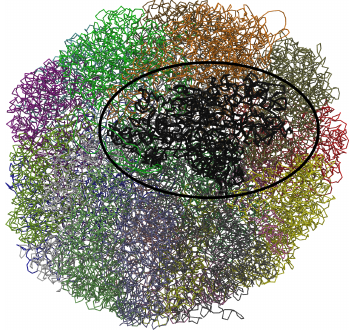
Figure 1. Structure of the intact genome of model 3 from cell No. 2. Chromosomes are shown in different colors [49]. Chromosome 14 (colored black), which is studied in this paper, is shown with thicker lines and is highlighted using a black